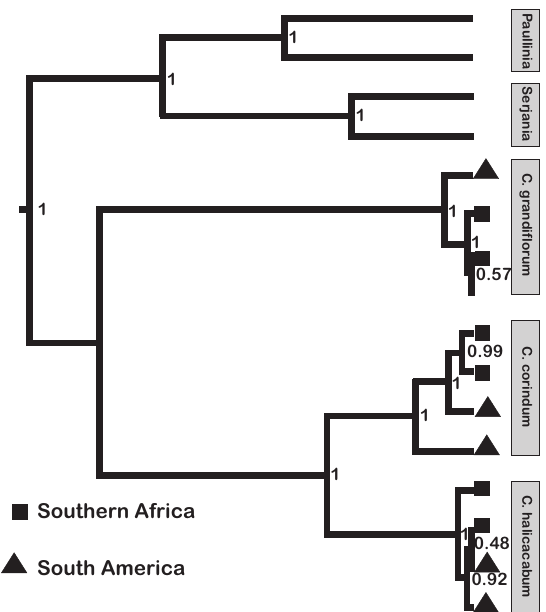
Figure 3. Cardiospermum phylogeny. Phylogeny of six South American and six southern African ac- cessions of Cardiospermum species with Paullinia and Serjania species used as outgroup taxa. Topology support is shown as posterior probability at each